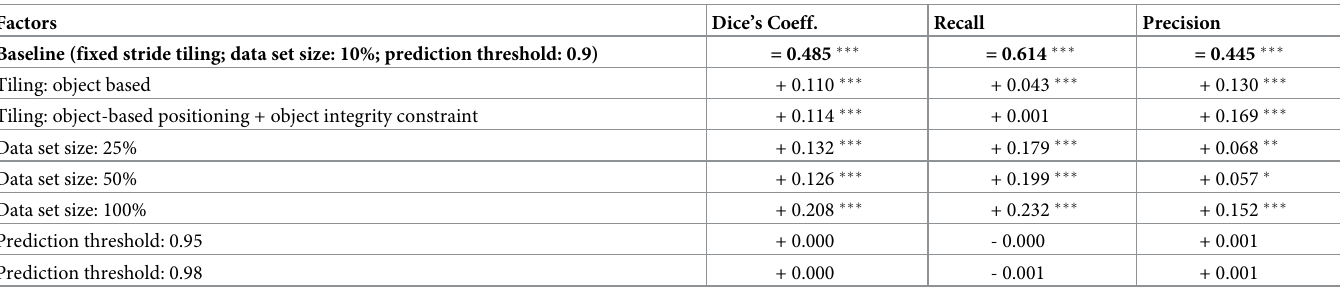
Table 4. Effects of tiling method, training data set size and prediction threshold on the segmentation performance of the U-Net models. Factors Dice’s Coeff. Recall